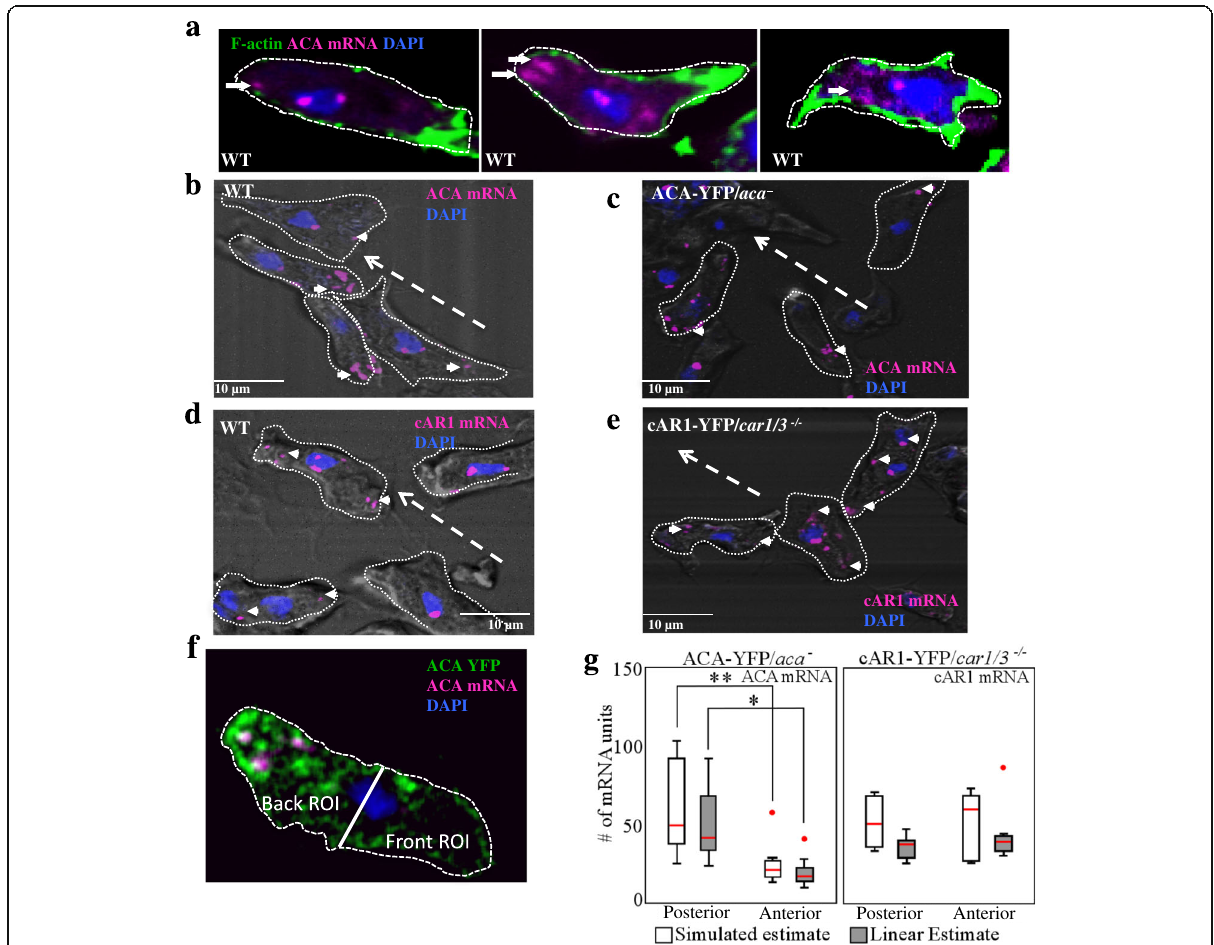
Fig. 1 ACA mRNA is spatially localized to the posterior of polarized chemotaxing cells. a Representative maximum intensity projections of confocal fluorescent images of individual polarized WT cells depicting F-actin ( green ), DAPI ( blue ), and ACA mRNA ( pink ). The white arrows indicate the asymmetric distribution of the mRNA spots. Outline of the cells are shown in white dashed lines . Data are representative of at least 4 independent experiments. b - c Representative merged phase contrast and maximum intensity confocal fluorescent images depicting DAPI ( blue ) and ACA mRNA ( pink ), in WT (B) and ACA-YFP/ aca − cells (C). The direction of migration of the cells (indicated by the dashed white lines ) was determined by the position of the aggregation center towards which the cells were moving in these self-aggregating chemotaxis assays. The white arrows indicate the asymmetric distribution of the mRNA spots. Outline of the cells are shown in white dashed lines . Data are representative of at least 4 independent experiments. d - e Representative merged phase contrast and maximum intensity confocal fluorescent images depicting DAPI ( blue ) and cAR1 mRNA ( pink ) in WT (D) and cAR1-YFP/ car1/3 − / − (E) cells. Data are representative of at least 4 independent experiments. f Each cell was manually bisected, defining anterior and posterior ROI based on both the orientation towards the aggregate center and the relative posterior enrichment of ACA-YFP in the cell. g Simulated and linear estimates of mRNA units across cells is plotted for ACA-YFP/ aca − and cAR1-YFP/ car1/3 − cells. The boxes show the 50% confidence region from the median ( red line ). The bars cover a region with 99% confidence level from the median. All data points beyond this confidence level are considered as outliers and are shown as red dots. The statistical significance was inferred by the t-test: * represents p < 0.05 and ** represents p < 0.01 (n ACA = 33, n cAR1 =